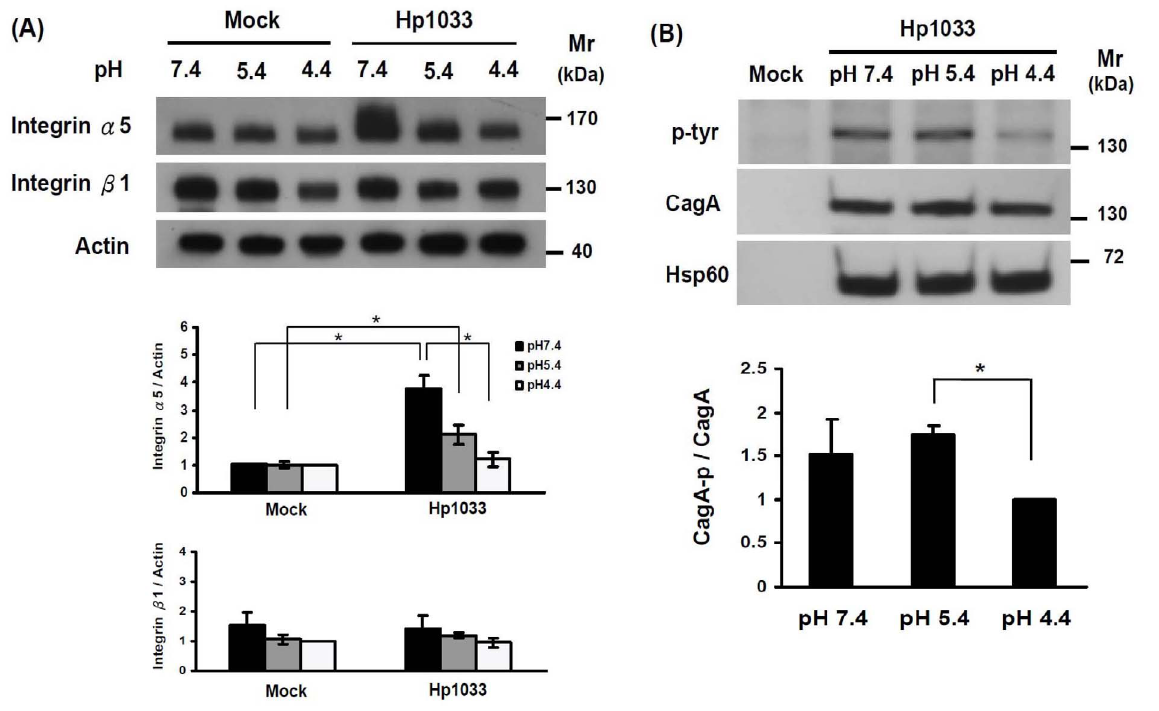
Figure 1. Integrin a 5 expression and CagA phosphorylation after H.pylori infection are pH dependent. ( A ) Integrin a 5 and b 1 expressions of AGS cells cultivated alone or co-cultivated with Hp1033 at pH 7.4, 5.4, and 4.4, respectively. Cell lysate was immunoblotted with an anti-integrin a 5 and anti- integrin b 1 antibody. GAPDH served as an internal control for sample normalization. The integrin a 5 expression was significantly higher in trend-like fashion as the pH elevated from 4.4, 5.4, to 7.4 (*indicated p , 0.05). ( B ) CagA phosphorylation of AGS cells co- cultivated with Hp1033 for 8 h at pH 7.4, 5.4 and 4.4, respectively. Cell lysate was immunoblotted with an anti-CagA, Hsp60 and anti-phospho-CagA antibody. The CagA phosphorylation at pH 5.4 was higher than that of pH 4.4 ( p , 0.05). The data are shown as mean value 6 standard deviation of the triplicate experiments.